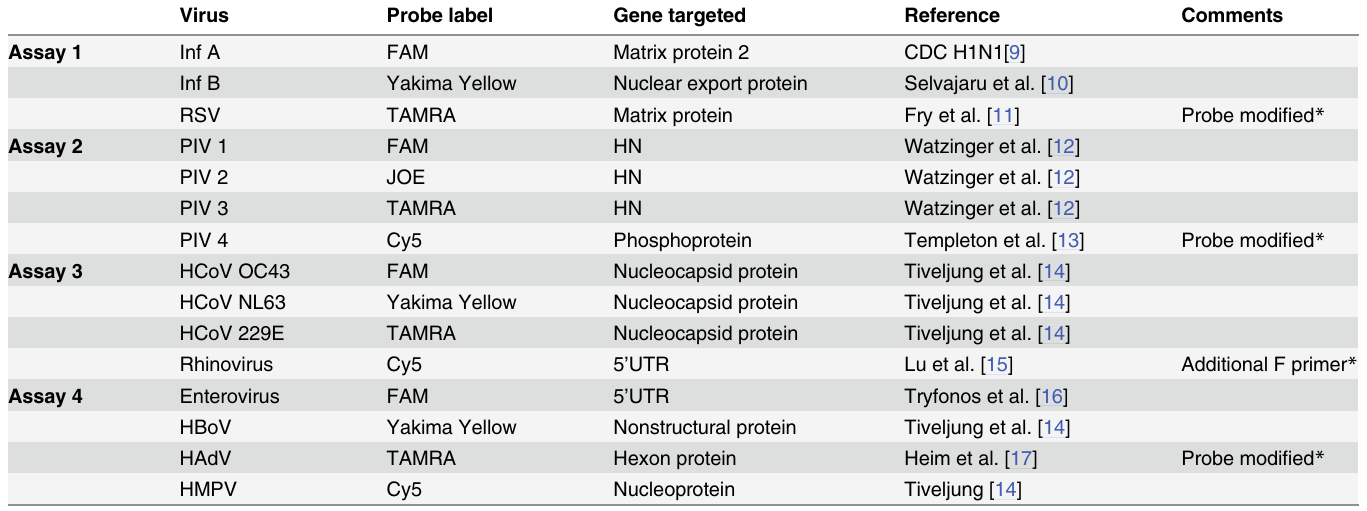
Table 1. Primers and probes used in four Multiplex-assays for the detection of 15 different viral pathogens. Virus Probe